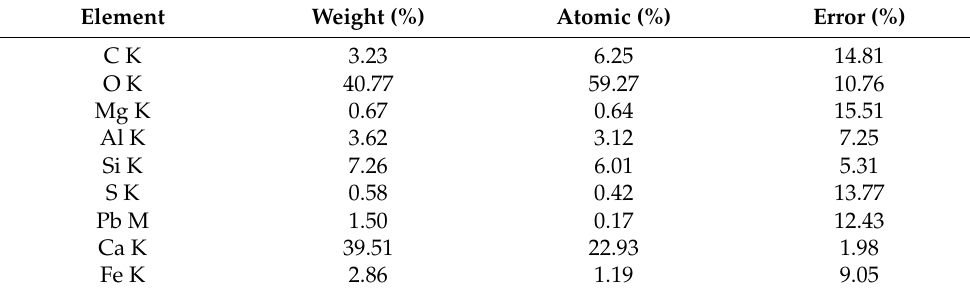
Table 5. EDAX results,0.6% Pb 2 O 3 (S5).